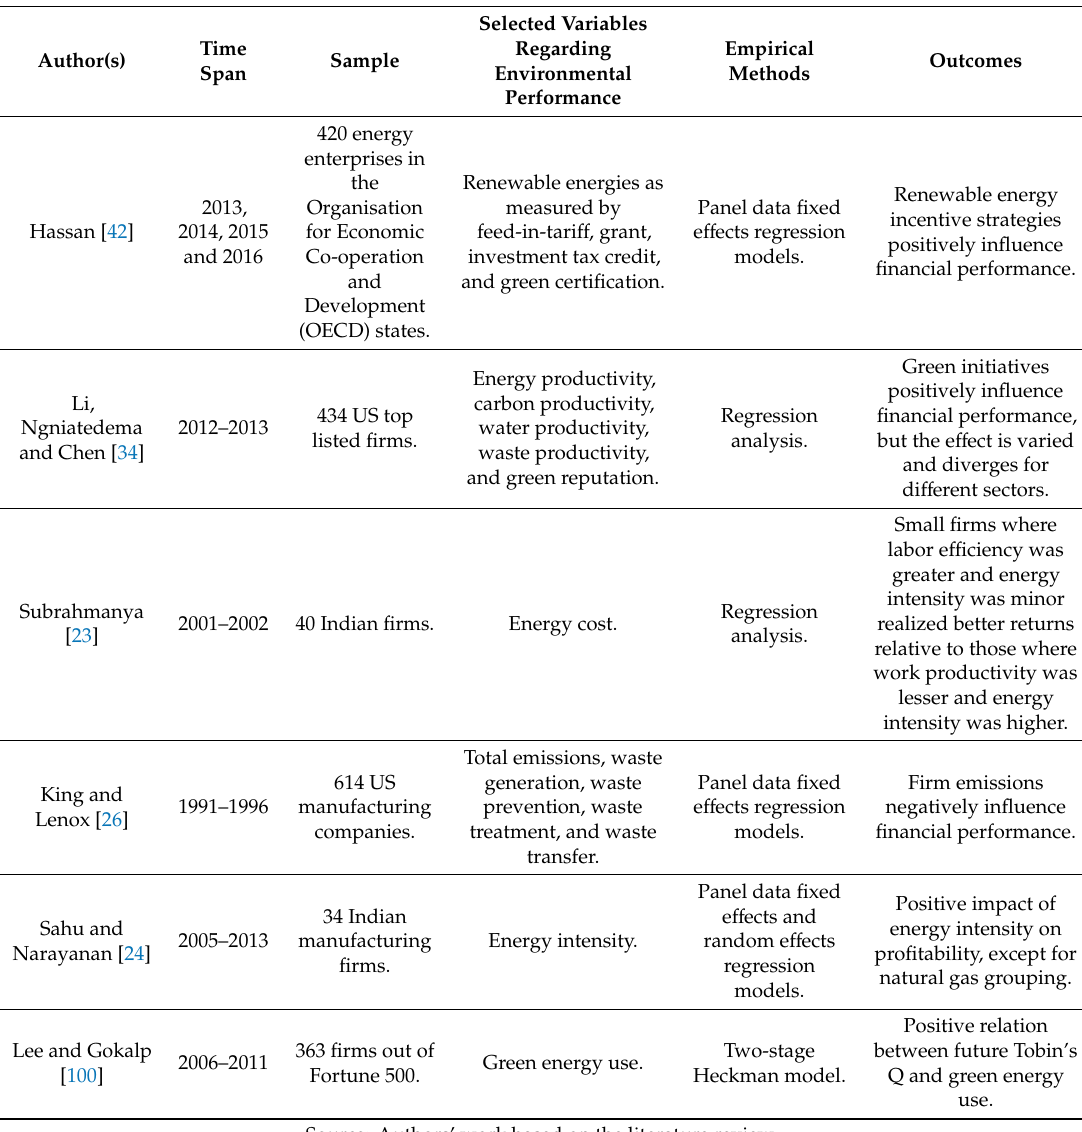
Table 3. Earlier literature on water, waste, and energy consumption-firm performance